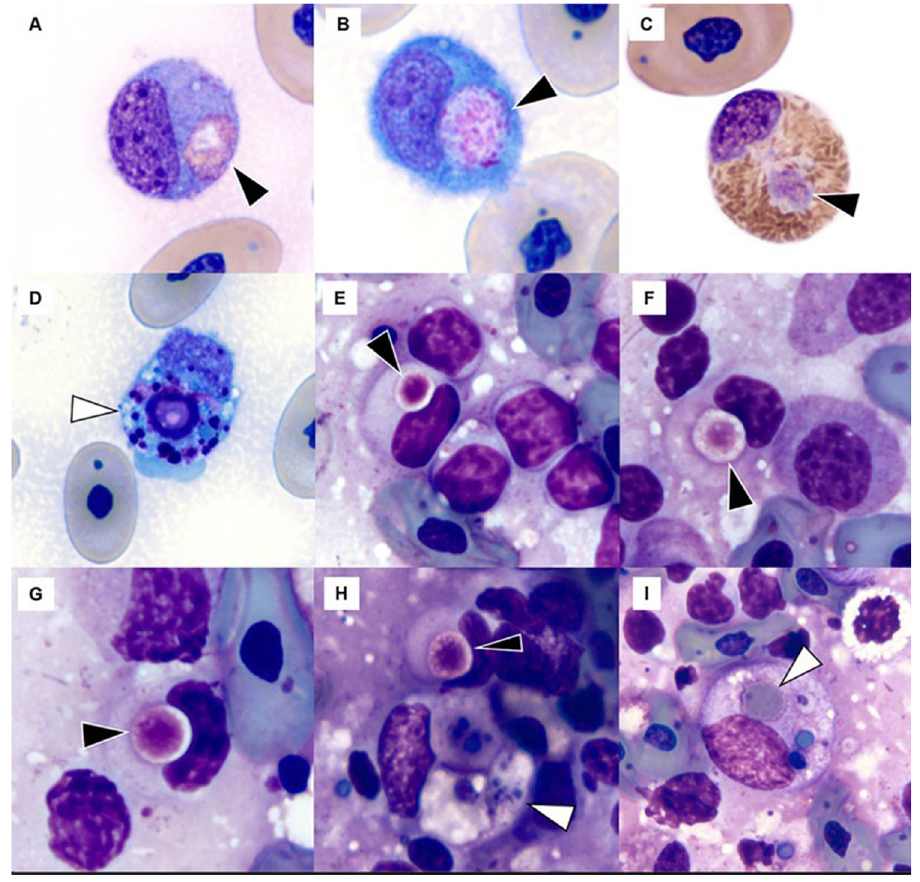
Fig 5. Image composite of inclusions observed in monocytes/histiocytes and heterophils of Florida softshell turtles ( Apalone ferox ) infected with Turtle fraservirus 1 (TFV1) in blood films (A-D) and splenic tissue imprints (E-I). Black arrowheads show inclusions of potential viral origin or viral-associated protein; white arrowheads indicate phagocytic activity. A-B) monocytes, C) heterophil, D) monocyte with non-specific cellular or nucleoproteinaceous debris, H-I) histiocytes with white arrowheads showing intracytoplasmic greenish-blue pigment suggestive of hemosiderin with I) also including a fragment of an erythrocyte in addition to presumptive hemosiderin. Wright-Giemsa stain, 100x